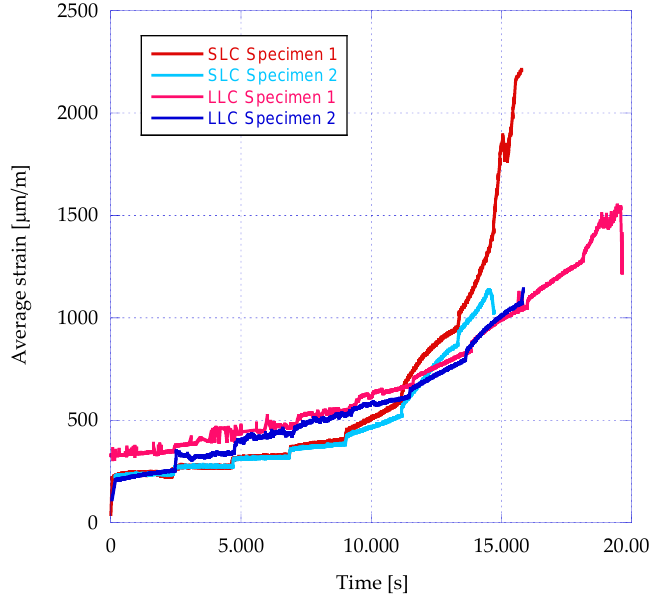
Figure 8. Evolution of mean strain for LLC and SLC mixes.